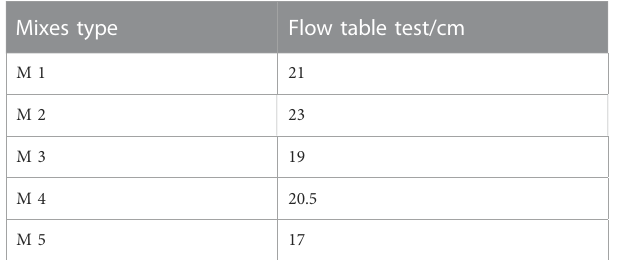
A sample of modulus of elasticity